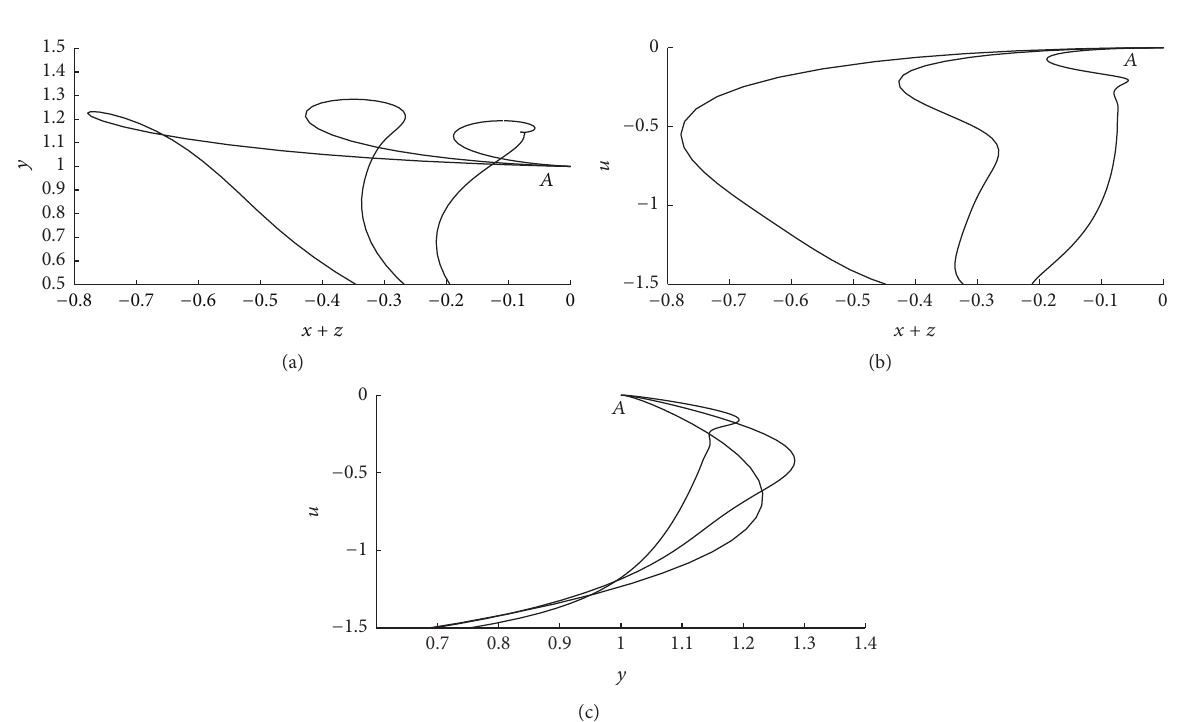
Figure 1: Two-dimensional projections of the phase-space trajectories for stability condition 𝜉 = 0.15 and for present day values 𝛽 = 14.5 , = 0.3 . All plots begin from the critical point 𝐴 being a stable attractor. 𝛾 = 1.5 , and Ω 𝑚